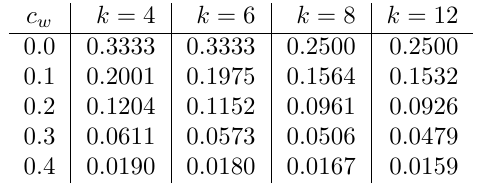
Figure 12: Running time exponent log T